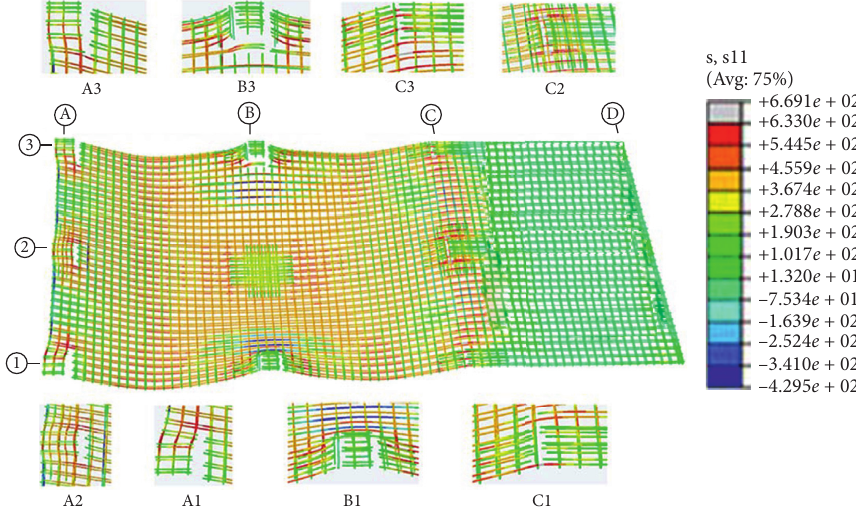
Figure 10: Stress state of slab bars at station E in model RI.